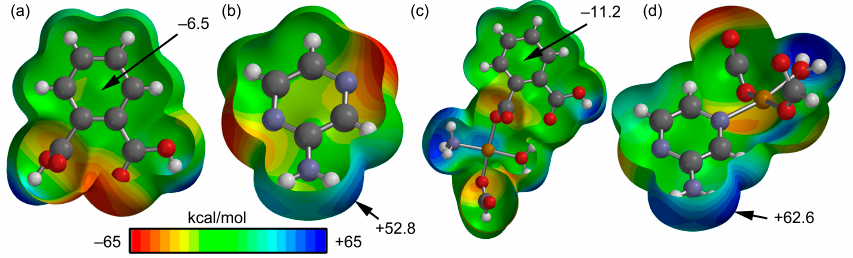
Figure 8. Molecular electrostatic potential (MEP) surfaces computed using the 0.002 a.u. isosurface for ( a ) phthalic acid, ( b ) aminopyrazine, ( c ) phthalate coordinated to Cu(II) and ( d ) aminopyrazine coordinated to Cu(II). The values of MEP at selected points of the surfaces are given in kcal/mol. The level of theory is